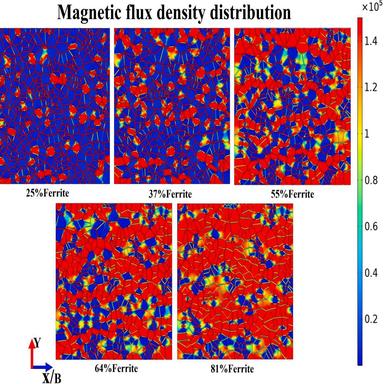
Magnetic flux density distribution of 2D FE model with different phase fractions (ferrite–austenite).